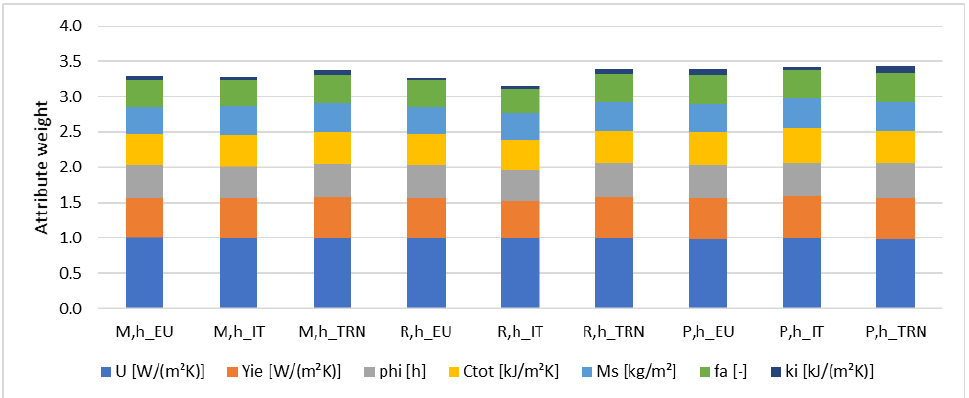
Figure 12. Weight analysis of the thermo-physical attributes of opaque structures, for the winter period and with g gl,n = 0.77.